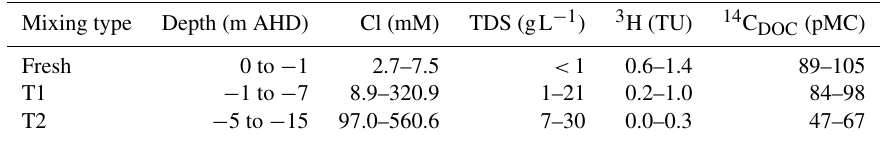
Table A1. Groundwater mixing types (Bryan et al., 2017).